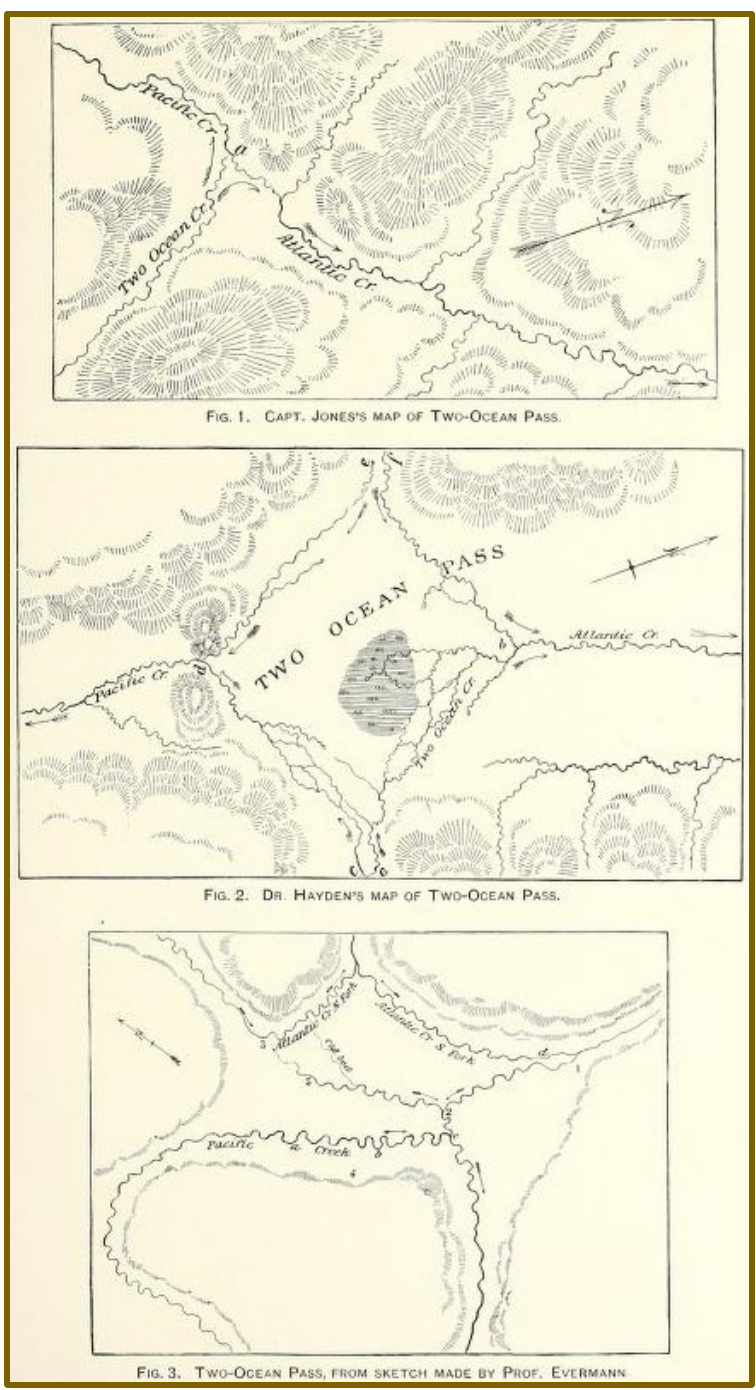
Figure A1. After first being described in an 1868 report on early explorations of the upper Yellowstone River region by the United States Secretary of War [108], hand-drawn maps of Two Ocean Pass were created in 1873 (Figure 1 Jones), 1878 (Figure 2 Hayden), and 1891 (Figure 3 Evermann), recreated here from [15].